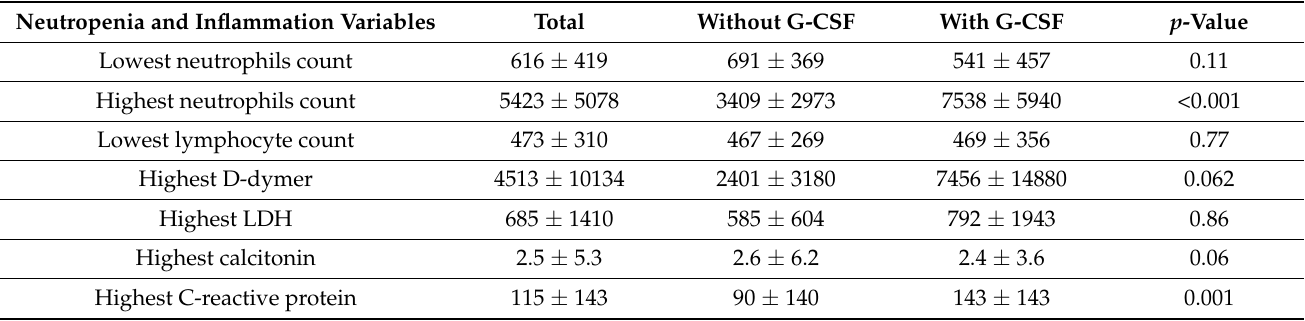
Table 3. Descriptive analysis of neutropenia